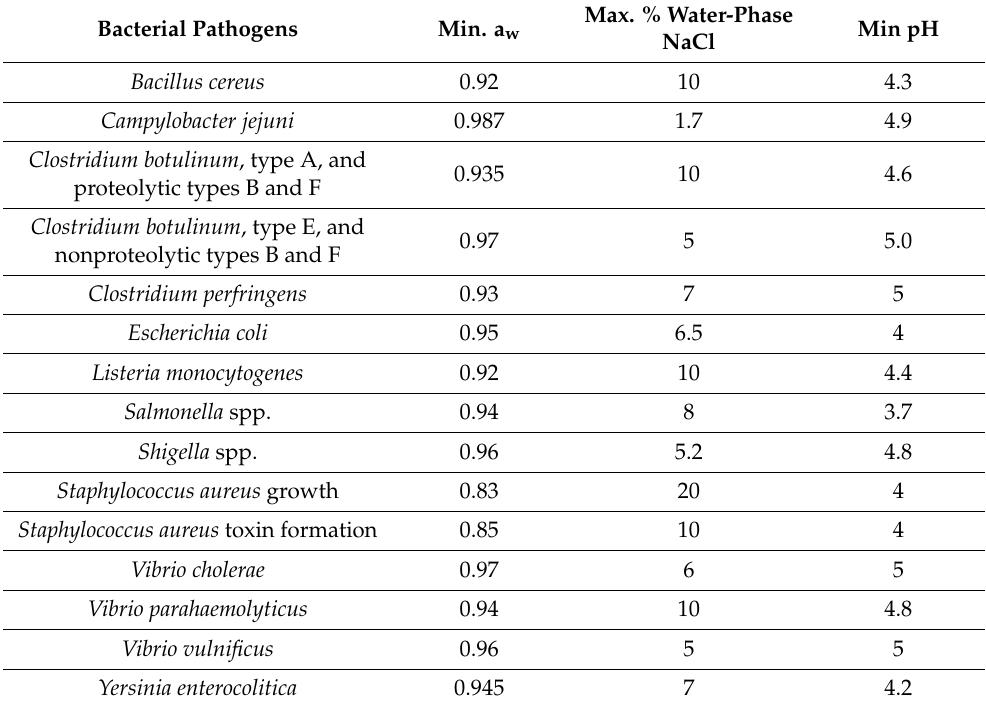
Table 2. Limiting conditions regarding a w for the growth of bacterial pathogens (adapted from Table A-1 in (FDA, 2011)